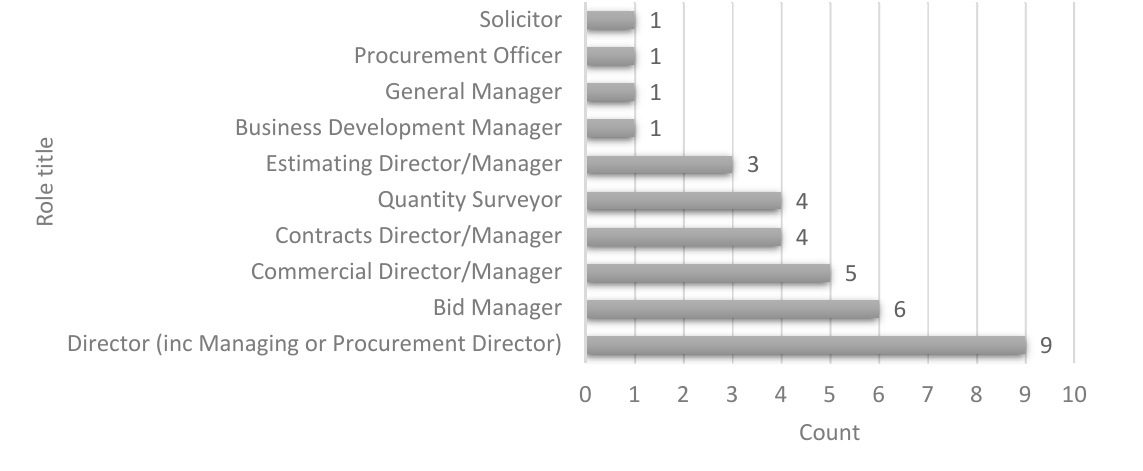
Figure 8. Respondents by role title.